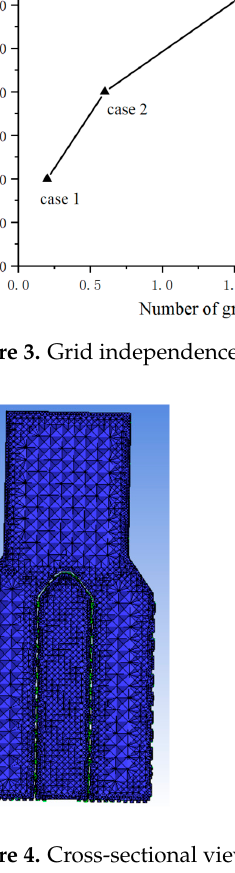
Figure 4. Cross-sectional view of muffler